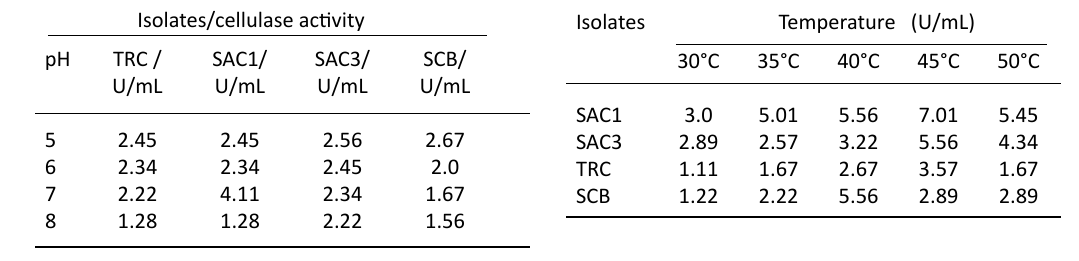
table 1. Consequence of diverse initial pHs on cellulase production Isolates/cellulase activity